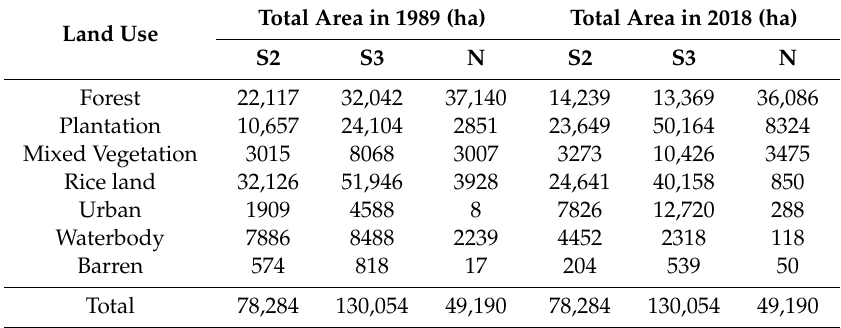
Table 6. The coverage area of land use types in each suitability level for rice land in 1989 and 2018.